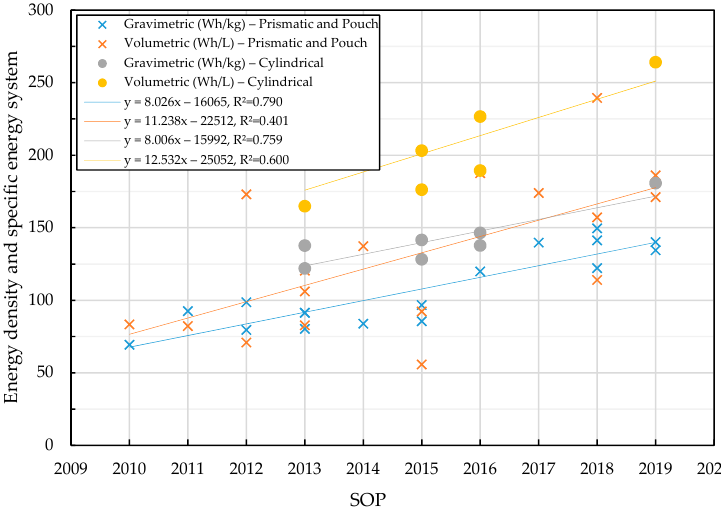
Figure 6. Development on system level in the years between 2010 and 2019.